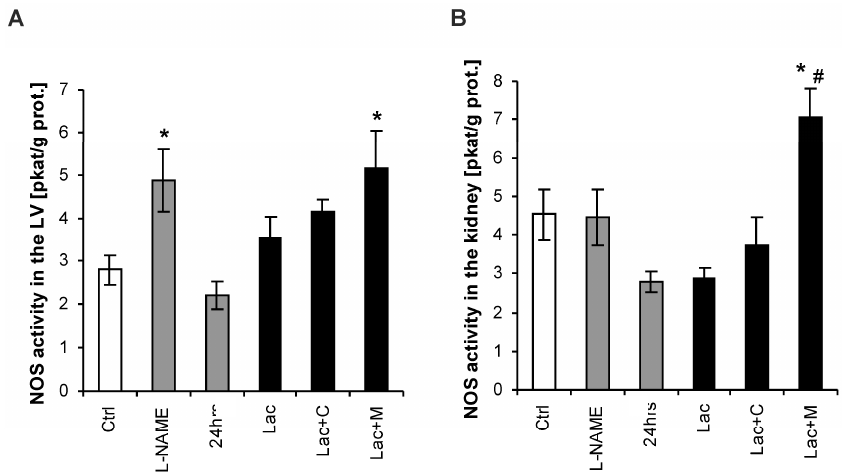
Figure 4. Nitric oxide synthase (NOS) activity in the heart ( A ) and kidney ( B ) in the control group (Ctrl), L-NAME (L-NAME)-, continuous 24 h/day light (24 h)-, lactacystin (Lac)-induced hypertension and in lactacystin-hypertension influenced by captopril (Lac+C) or melatonin (Lac+M). * p < 0.05 vs. Ctrl, # p < 0.05 vs. Lac.